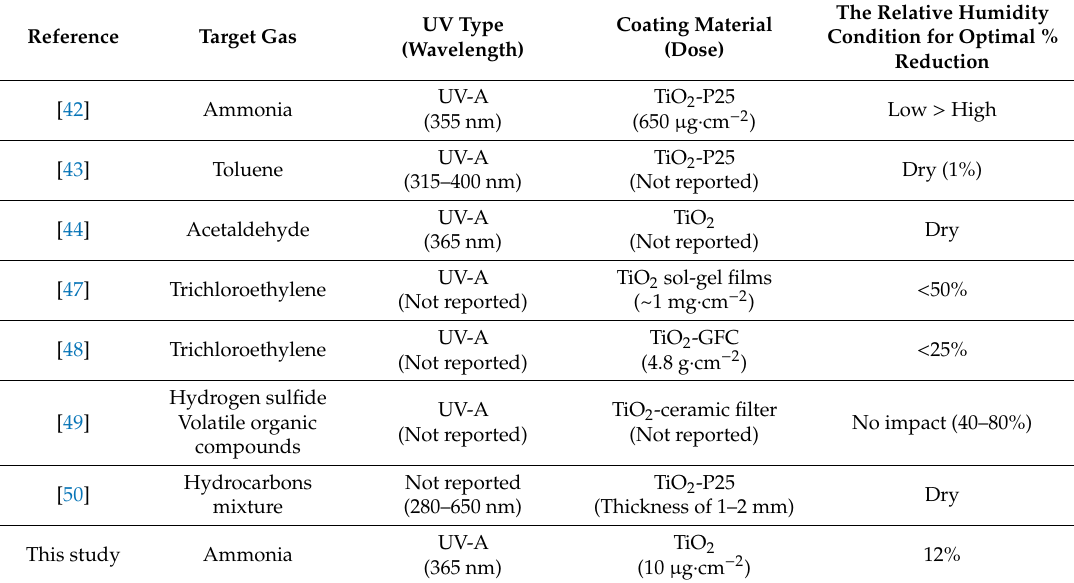
Table 5. Comparison of optimum relative humidity for each target gases in the